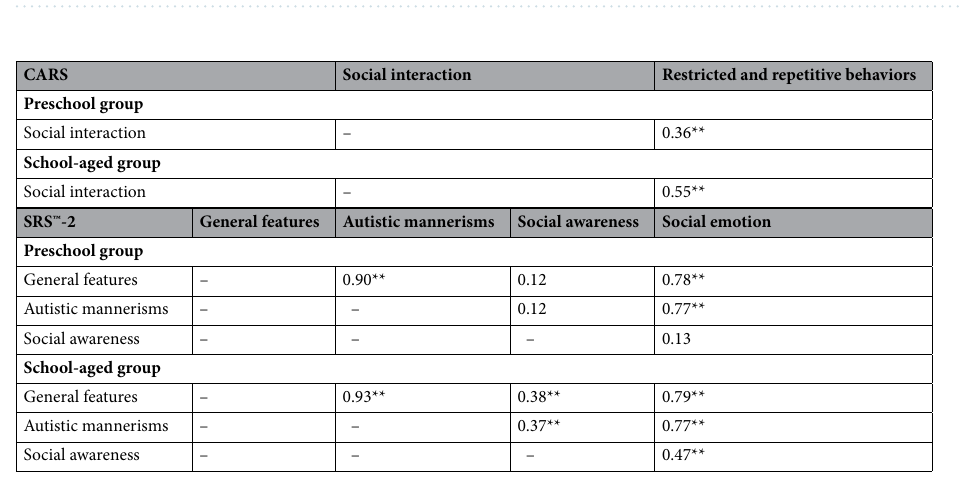
Table 1. Characteristics of the participants (N = 108). CARS: Childhood Autism Rating Scale, SRS™-2: Social Responsiveness Scale.